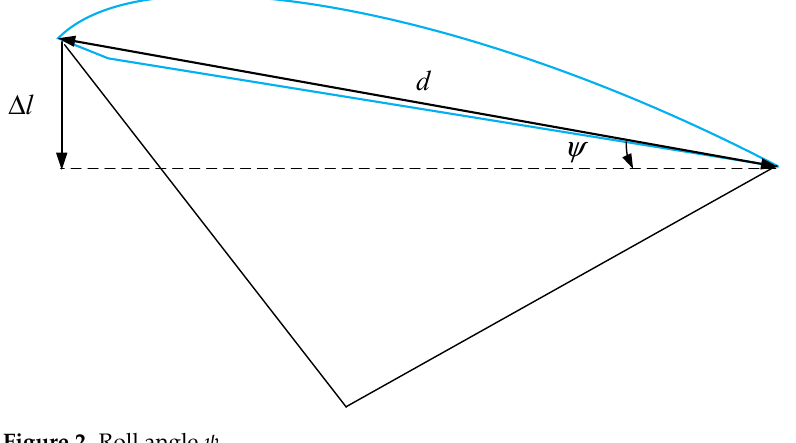
Figure 2. Roll angle ψ .